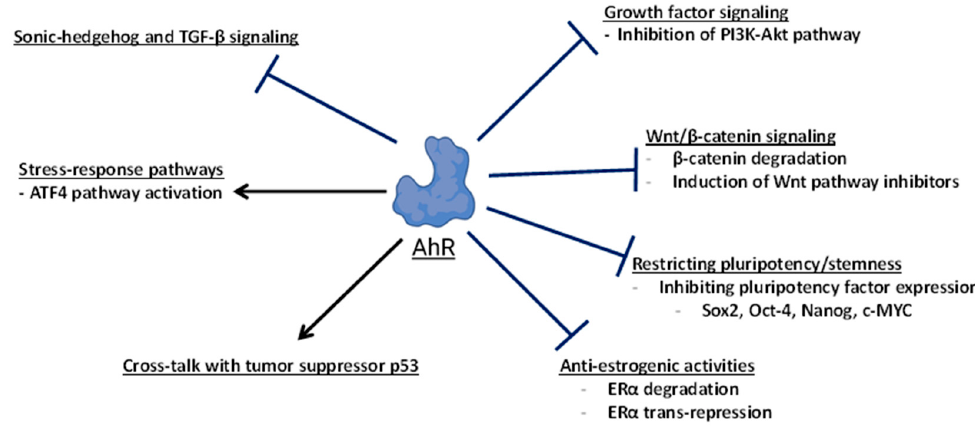
Figure 6. Pathways and targets of AhR-dependent tumor suppression. This diagram broadly summarizes the mechanisms and molecular targets of AhR involved in suppressing carcinogenesis or tumor growth.